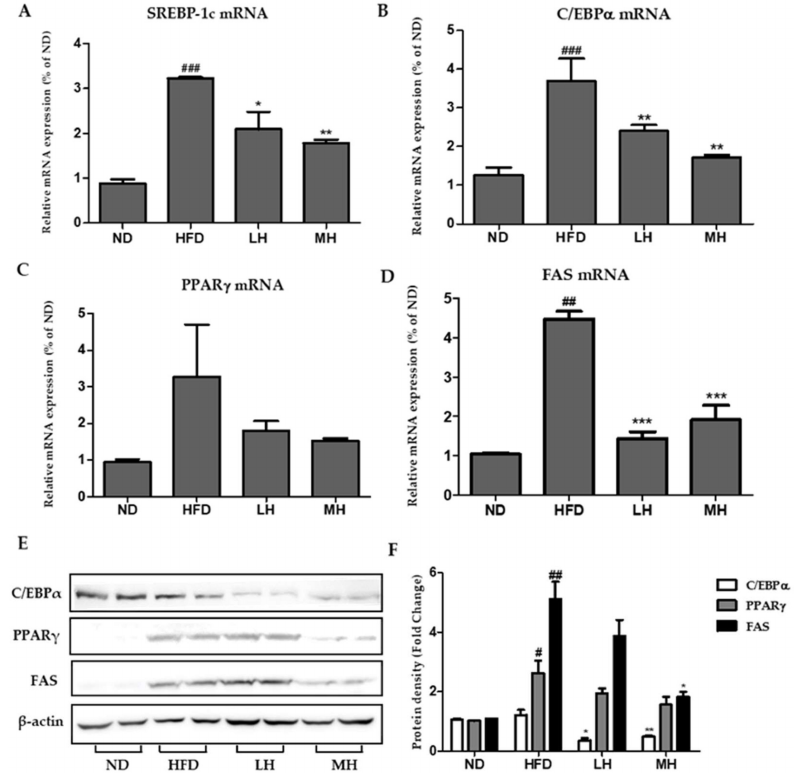
Figure 7. Effects of HBE on the expression of genes associated with lipogenesis in HFD-fed mice. ( A – D ) The expression of SREBP-1c ( A ), C/EBP α ( B ) , PPAR γ ( C ), and FAS ( D ) were quantified by real-time PCR and normalized by β -actin as an internal control. ( E ) C/EBP α , PPAR γ , and FAS protein levels by Immunoblot analysis. ( F ) Protein density of C/EBP α , PPAR γ , and FAS. Equal loading of protein was verified by probing β -actin. ND, normal diet control; HFD, high-fat diet; LH, HFD-supplemented 0.5% HBE; MH, HFD-supplemented 1% HBE. Data represent means ± SD. # p < 0.5, ## p < 0.01, ### p < 0.001 vs. ND; * p < 0.5, ** p < 0.01, *** p < 0.001 vs.